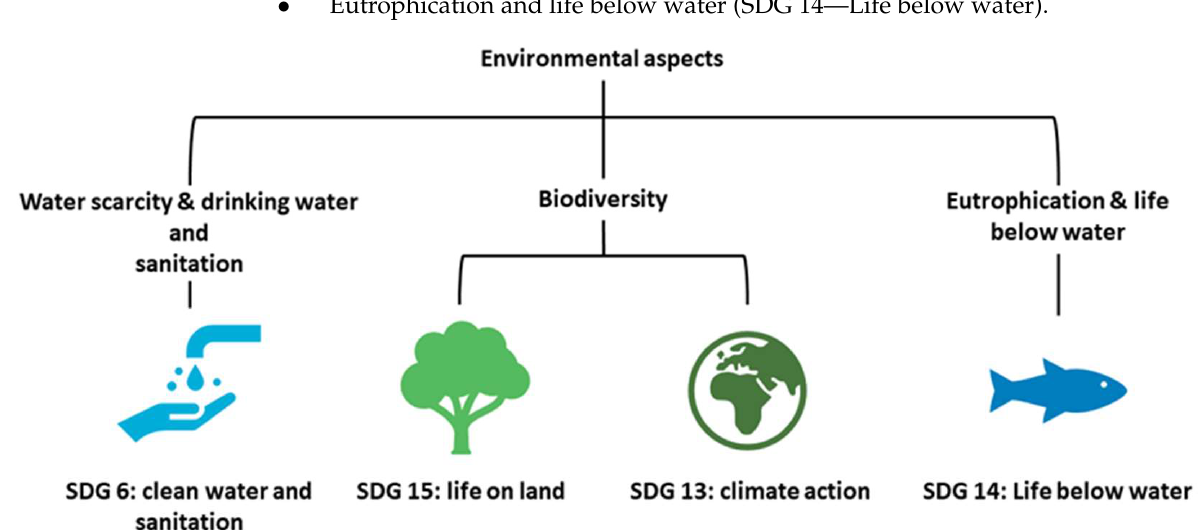
Figure 6. An overview of the environmental aspects and the corresponding Sustainable Development Goals (SDGs) included in the following section.